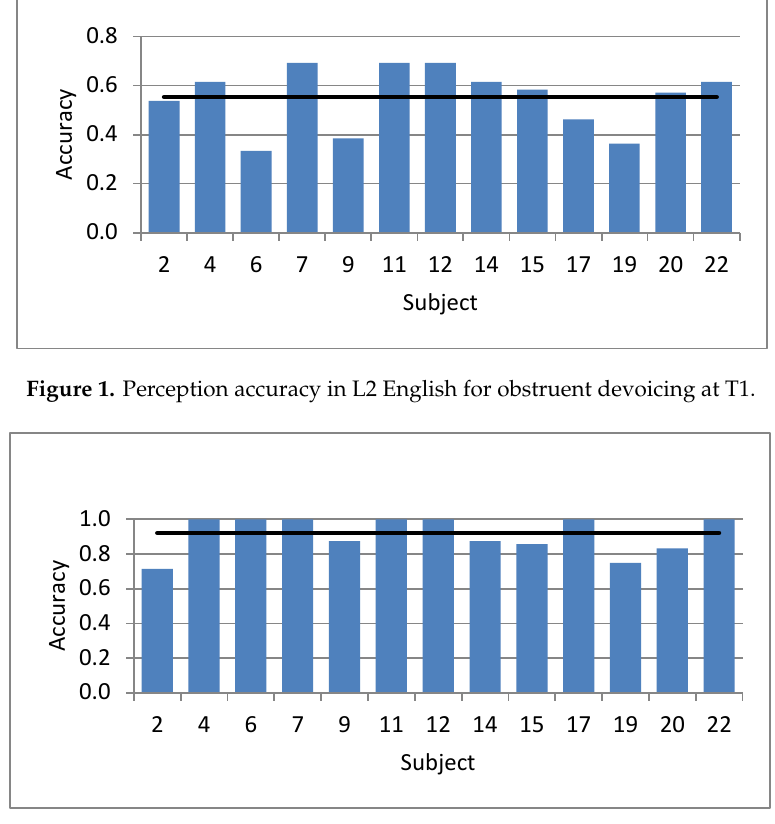
Figure 2. Perception accuracy in L2 English for rhotics at T1.